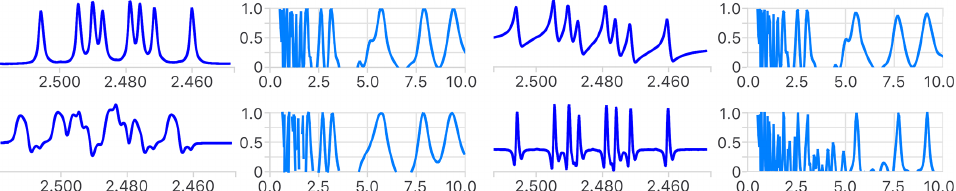
Figure 4. Comparison of the first step of the analysis of the reference multiplet before (top left) and after introduction of a phase error (top right), a distorted line shape (bottom left) and using its second derivative (bottom right). The measured coupling constants are the same in all cases (not shown), as the position of extrema in the four error functions shows. The narrower extrema of the error functions in the latter indicate a higher potential to identify small coupling constants. See Fig. S1 for a more detailed analysis.